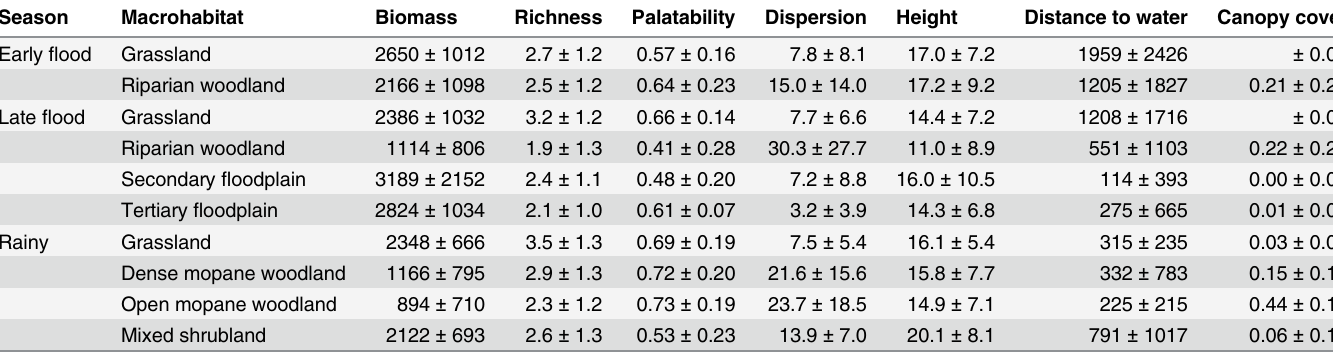
Table 1. Vegetation characteristics in different seasonally-preferred macrohabitats.